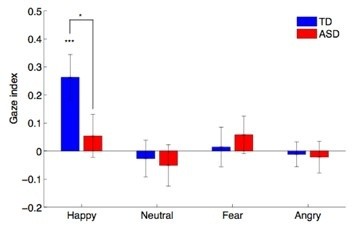
Gaze index.Blue, TDs; red, ASDs. Gaze index measures the specificity of the modulation of pupillary response by gaze direction for each emotion. TDs show happy-specific gaze modulation. The error bars indicate standard error of the mean